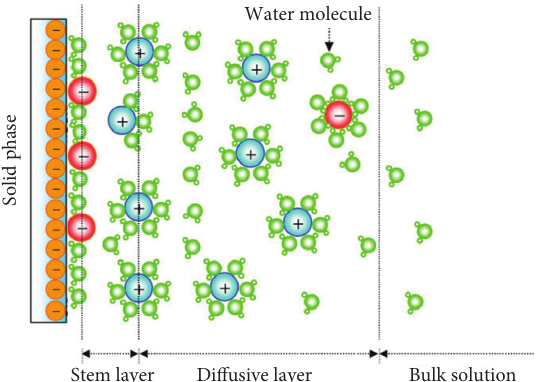
Figure 15: Schematic diagram of the water film on the surface of the sludge particles